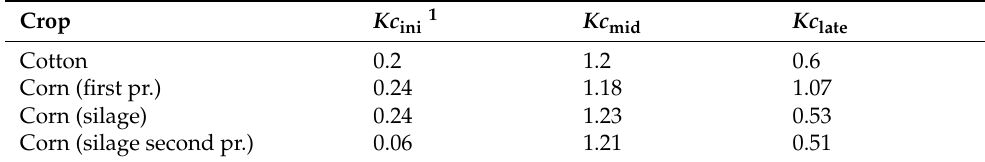
Table 1. Crop coefficient for different stages. Crop Kc ini 1 Kc mid Kc late Cotton 0.2 1.2 0.6 Corn (first pr.) 0.24 1.18 1.07 Corn (silage) 0.24 1.23 0.53 Corn (silage second pr.) 0.06 1.21